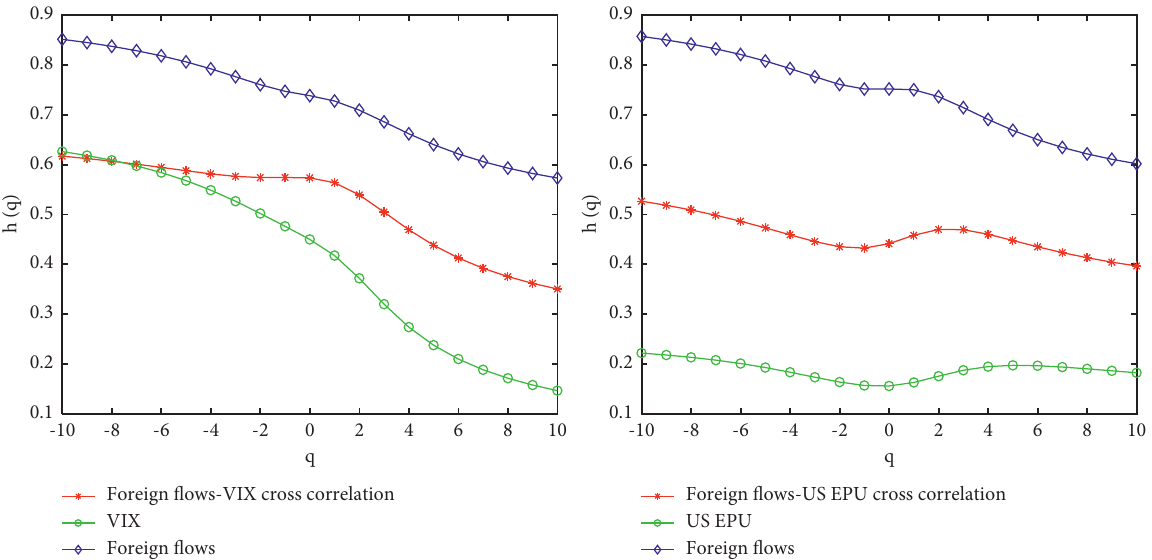
Figure 4: The generalized Hurst exponent of H ( q ) versus q for the foreign flows in A-share market and VIX and the foreign flows in A-share market and US